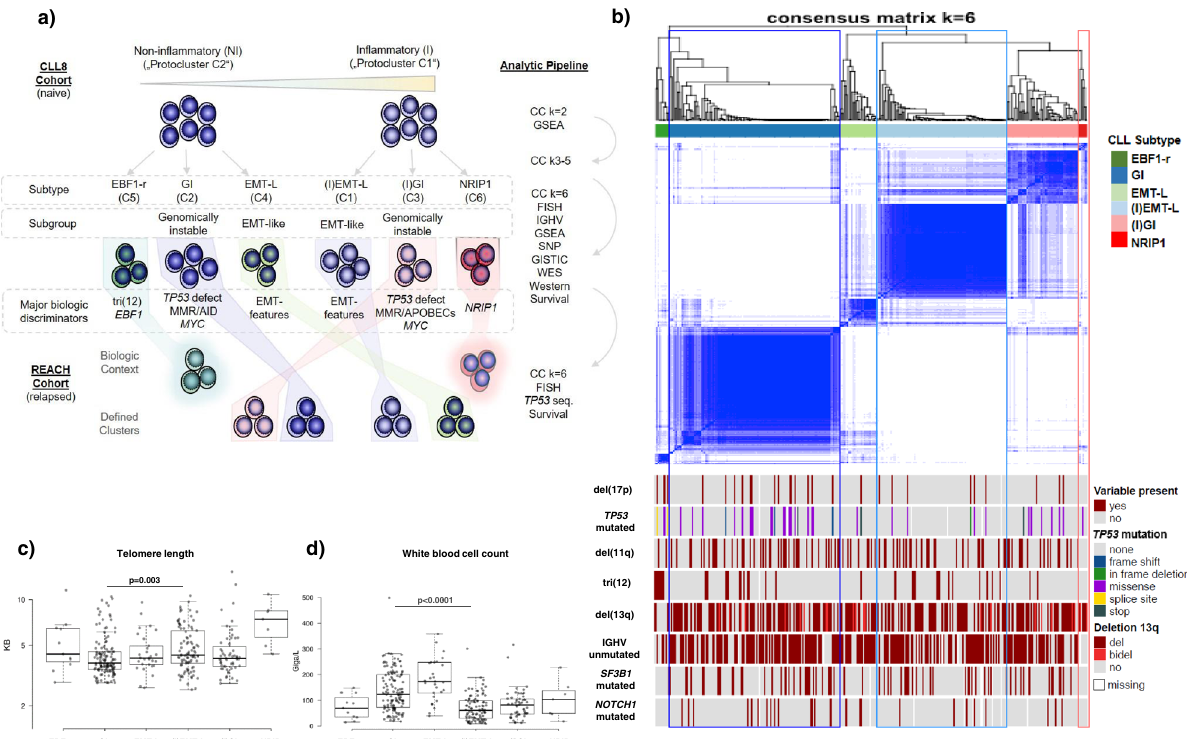
Fig. 1 Composition and relationship of CLL subtypes in clustered data. a Schematic representation for analysis, identi fi cation of CLL subtypes in the CLL8, and con fi rmation in the REACH cohort. The four largest clusters (GI, (I)GI, EMT-L, (I)EMT-L), and associations of NRIP1 with the in fl ammatory or tri(12) with the EBF1-r signature were also identi fi ed in the independent validation cohort of the REACH trial. Co-clustering of GI/(I)GI and EMT-L/(I)EMT-L cases in the REACH cohort supports the selection of subgroup-speci fi c characteristics during treatment. b Heatmap showing the consensus clustering for k = 6 used for de fi ning CLL subtypes ( n = 337). The distribution of genetic characteristics is shown below the heatmap. Signi fi cant enrichment of variables in clusters is observed for del(17p) ( p = 0.05), TP53 mutation ( p = 0.01), tri(12) ( p = 7e − 06), del(13q) ( p = 0.03), and IGHV mutation status ( p = 0.008) (all Fisher ’ s exact test (two-sided)). TP53 frameshift mutations occur exclusively in GI and splice site mutations in EBF1-r cases. Tri(12) is strongly overrepresented in EBF1-r (72.7%). c Telomere length is signi fi cantly different across CLL subtypes ( p < 0.001, Kruskal – Wallis test), and shortest length is observed in GI with a median of 3.8 kb ( p = 0.003, Mann – Whitney (two-sided), for GI vs. (I)EMT-L) ( n = 333). d White blood cell counts are signi fi cantly different across CLL subtypes (p < 0.0001, Kruskal-Wallis test), show decreased counts in in fl ammatory CLL and are lowest in (I)EMT-L with median 61.1 G/L ( p < 0.0001, Mann – Whitney (two-sided), for GI vs. (I)EMT-L) ( n = 330). For Fig. 1a – d, data within individual fi gures derives from biologically independent samples. For the boxplots, centerline, box limits, and whiskers represent the median, 25th, and 75th percentiles, and 1.5× interquartile range,